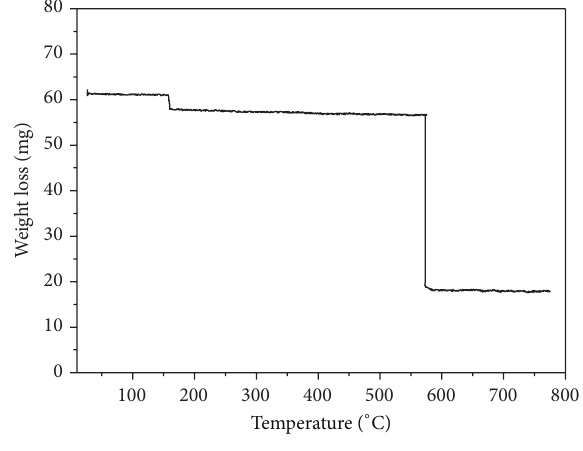
Figure 1: DSC diagrams of commercial PVC and polymer (P 2 ). Figure 2: TG curves of polymer (P